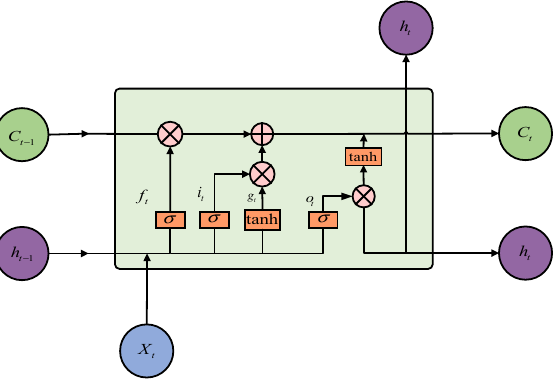
Figure 6. The LSTM net structure.